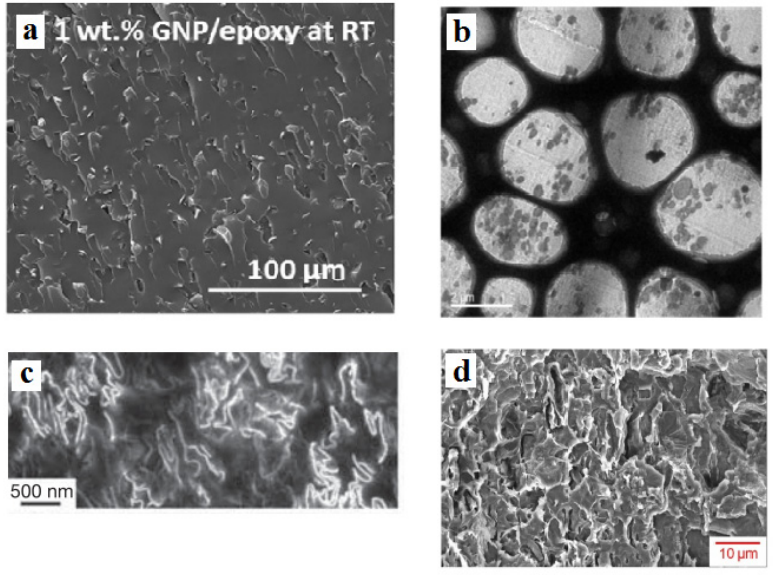
Figure 8. Morphological images of ( a ) epoxy [49], ( b ) ABS [50], ( c ) PS [51], and ( d ) PVDF [28] gra- phene systems. graphene systems.